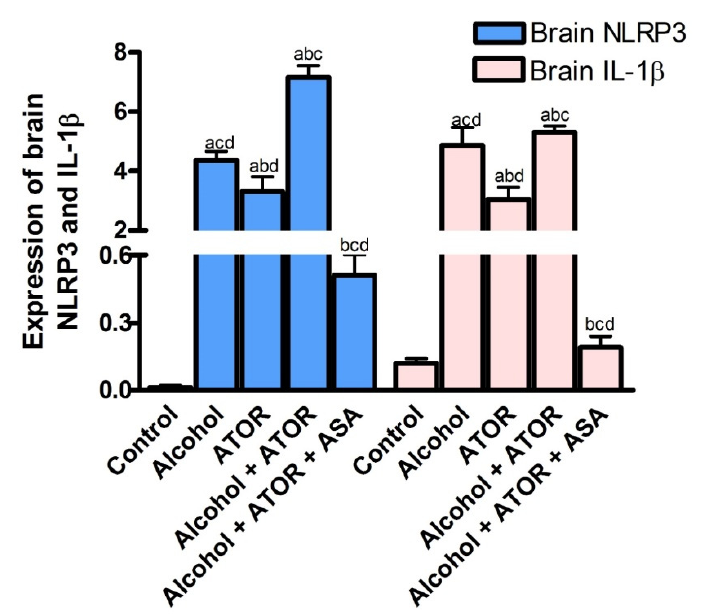
Figure 2. Effect of alcohol and/or ATOR administration on the expression of brain NLRP3, and IL-1 β and assessment of ASA treatment (mean ± SD). Data are mean ± SD of 6 rats per group. p < 0.05 is significant; a p versus control group, b p versus Alcohol group, c p versus ATOR group, d p versus Alcohol + ATOR + ASA group.